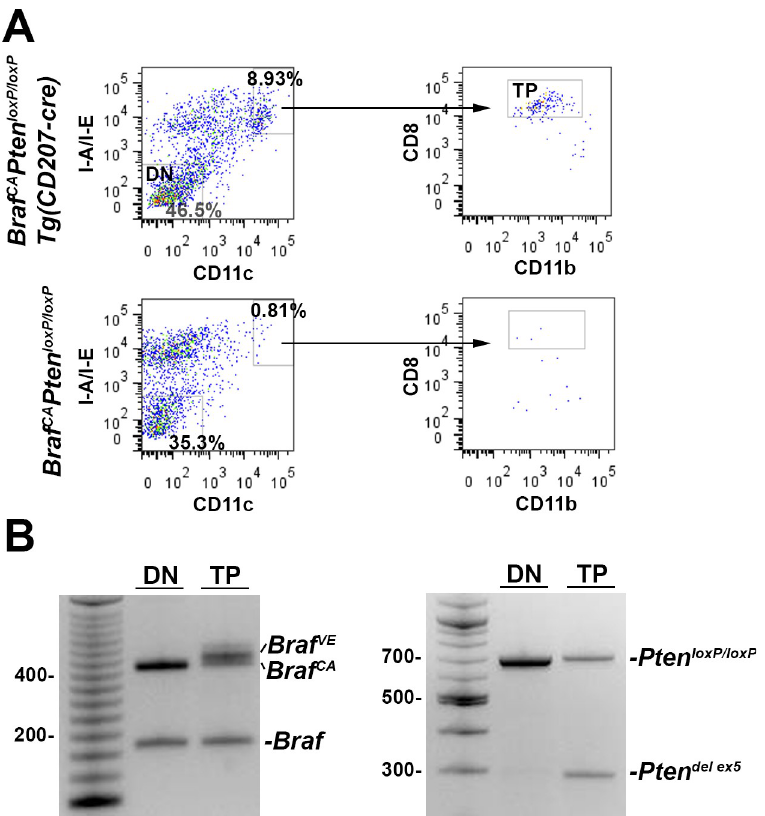
Fig 16. Rearranged Braf and Pten loxP/loxP alleles in the I-A/I-E + /CD11c + /CD8 + cells from the spleens of Braf CA Pten loxP/loxP Tg(CD207-cre) mice. A. Cells from the spleens of 37 day old Braf CA Pten loxP/loxP Tg(CD207-cre) and Braf CA Pten loxP/loxP mice were sorted for I-A/I-E and CD11c expression. Double Negative (DN) cells are indicated for the Braf CA Pten loxP/loxP Tg(CD207-cre) cells. The double positive cells were then sorted for CD8 and CD11b expression. The CD8 + cells from Braf CA Pten loxP/loxP Tg(CD207-cre) spleens are designated as Triple Positive (TP). B. Double Negative (DN) and Triple Positive (TP) cells from A were analyzed by PCR for the presence of Braf and Pten alleles. Cre- mediated rearrangement both alleles was observed in the TP, but not the DN cells.